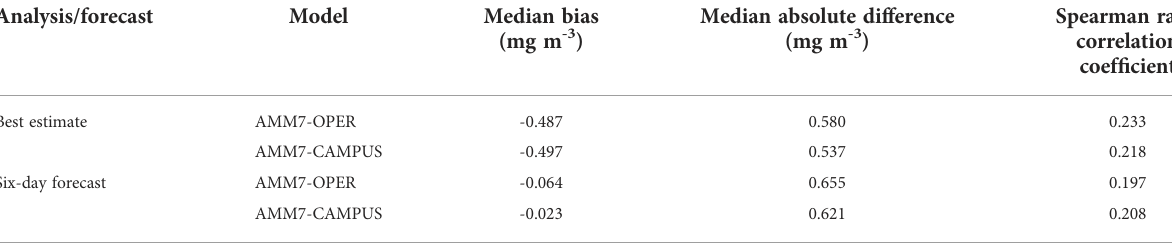
TABLE 2 Validation statistics for AMM7-OPER and AMM7-CAMPUS chl- a against L4 data. Analysis/forecast